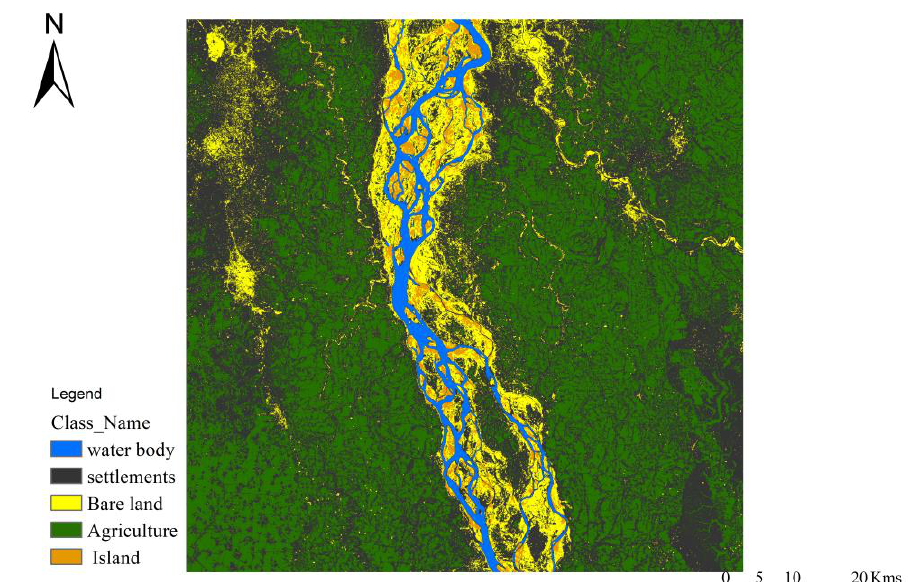
Fig. 4 . land use map of the study area.